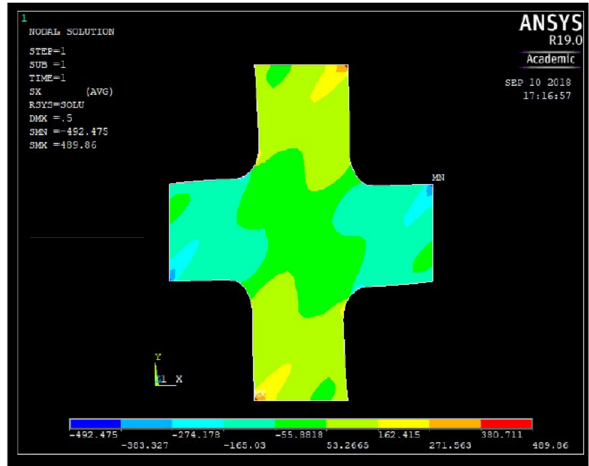
Figure 13: σ 11 contour plot in the cruciform coupon.